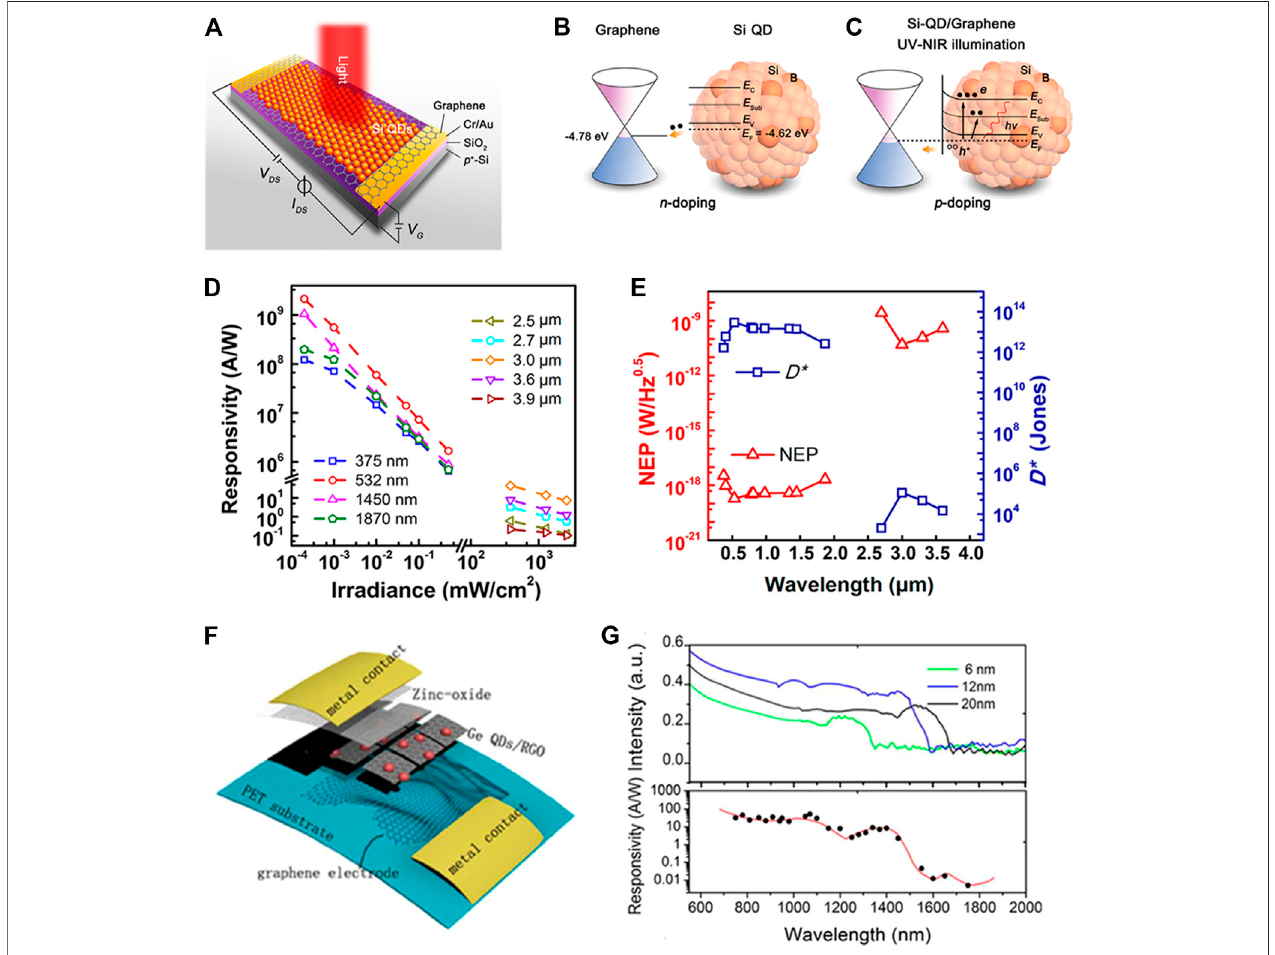
FIGURE9|(A) SchematicsofthehybridPD.EnergybanddiagramofgrapheneandSiQDsandschematicsofchargetransferintheheterostructure (B) indarkand (C) under UV-to-NIR illumination. (D) Responsivity of the device as a function of irradiance intensity. (E) NEP and speci fi c detectivity of the device as a function of wavelength. (F) Device schematics of the heterostructure PD. (G) Responsivity of the device as a function of wavelength. (A – E) Reprinted with permission from ACS Nano, 2017, 11, 9854 – 9862. Copyright 2017 American Chemical Society. (F – G) . Reprinted with permission from ACS Appl. Mater. Interfaces, 2015,